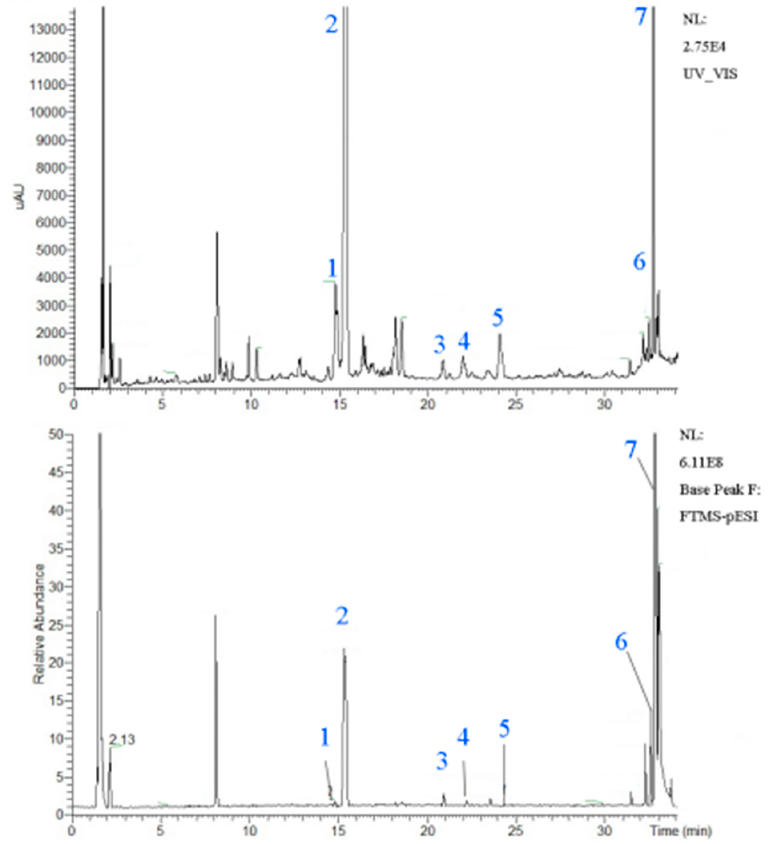
Figure 1. UHPLC-Q Extractive Orbitrap-HRMS Chromatograms of the licorice aqueous extract. The seven peaks correspond to ( 1 ) liquiritin apioside or isomer; ( 2 ) liquiritin; ( 3 ) isoliquiritin apioside; ( 4 ) isoliquiritin; ( 5 ) liquiritigenin; ( 6 ) isoliquiritigenin and ( 7 ) glycyrrhetinic acid. Table 1. Characterization of chemical constituents of licorice aqueous extract by UHPLC-Q Extractive Orbitrap-MS.